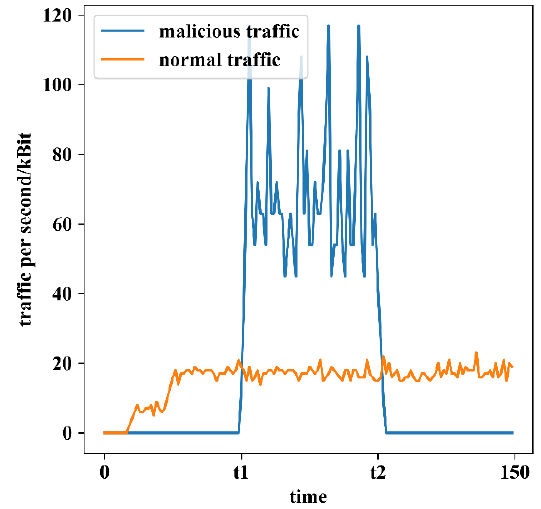
Figure 12. Network traffic statistics at IoT device B1.